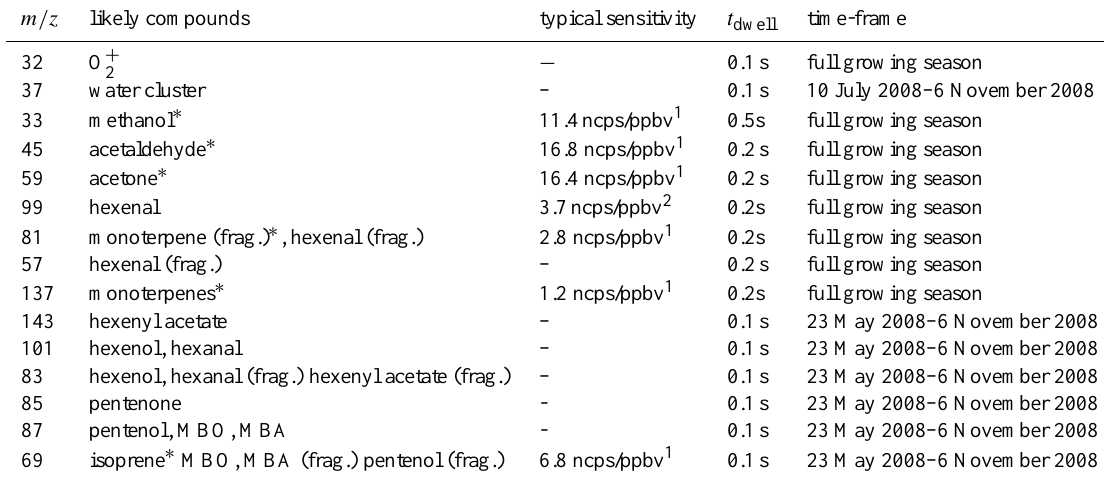
Table 1. List of the measured masses/compounds with typical sensitivities, dwell times ( t dwell ) and the time-frame in which they were measured.